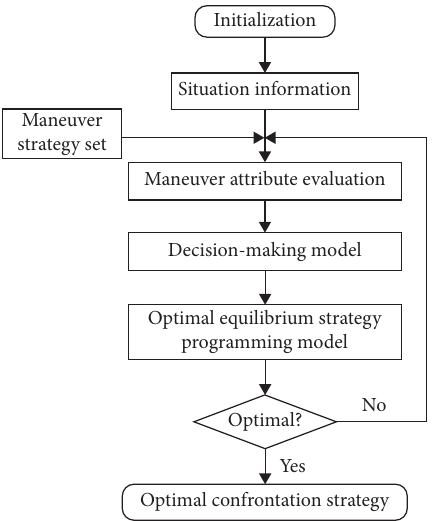
Figure 1: Multi-UUV cooperative dynamic maneuver decision- making.